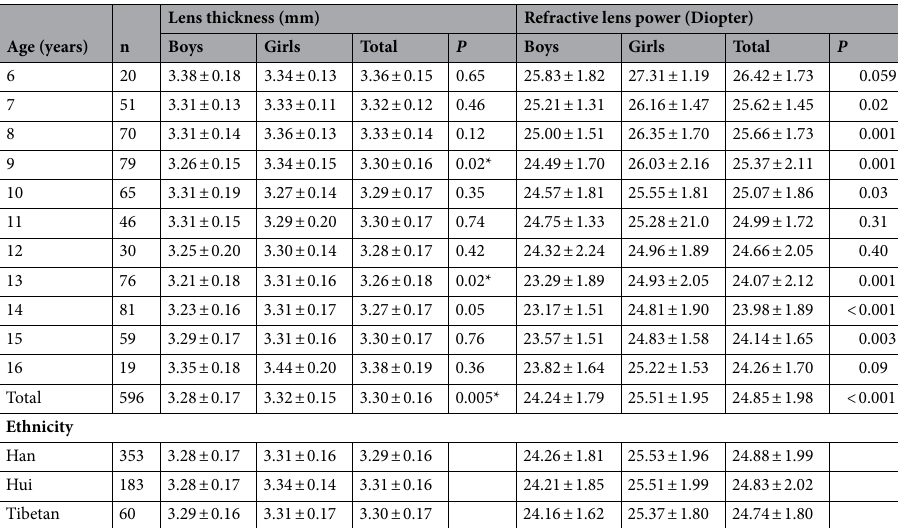
the final model, a higher lens thickness was associated with older age ( P < 0.001, β = 0.009), shorter axial length ( P < 0.001; β = − 0.052), longer corneal curvature radius ( P < 0.001; β = 0.115), and shorter anterior chamber depth ( P < 0.001; β = − 0.145) (Table 3). In univariate analysis, RLP decreased significantly with older age in the age group from age 6 to age 13 (cor- relation coefficient r = − 0.34; P < 0.001), while it plateaued in the age group of 13 to 16 years (Table 2) (Fig. 2B), with no significant difference between boys and girls. There were no significant differences in RLP between the ethnic groups ( P = 0.88). RLP, without significant difference between boys and girls, was significantly ( P < 0.001) higher than in myopic children (Table 4). It did not differ significantly between myopic children and highly myopic children or between children with medium to marked hyperopia and mild hyperopia ( P ˃ 0.05). In the multivariate regression analysis with the parameter of RLP as the dependent variable, we first dropped refractive error due to a collinearity with axial length (variance inflation factor (VIP): 11.87). We then removed step by step from the list of independent variables those parameters for which the P -value was > 0.05. In the final model, a higher RLP was associated with younger age ( P < 0.001, β = − 0.07), female sex ( P < 0.001; β = − 0.08), shorter axial length ( P < 0.001; β = − 0.483) and higher lens thickness ( P < 0.001; β = 0.42) (Table 5).